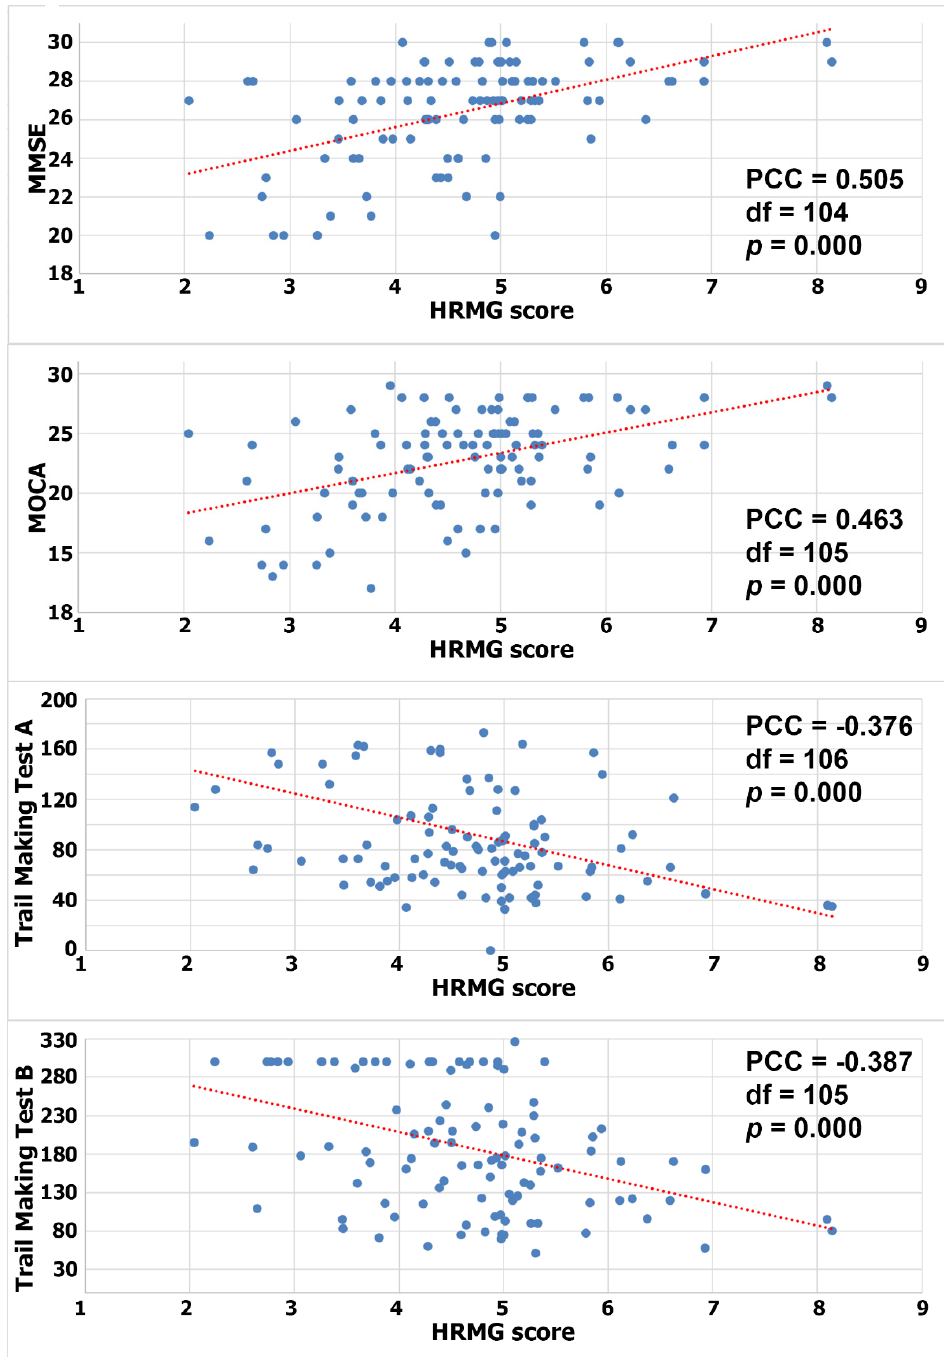
Figure 2. Correlation between High Resolution Monitoring Games and MMSE/MOCA/Trail Making A/Trail Making B, respectively (PCC: Pearson correlation